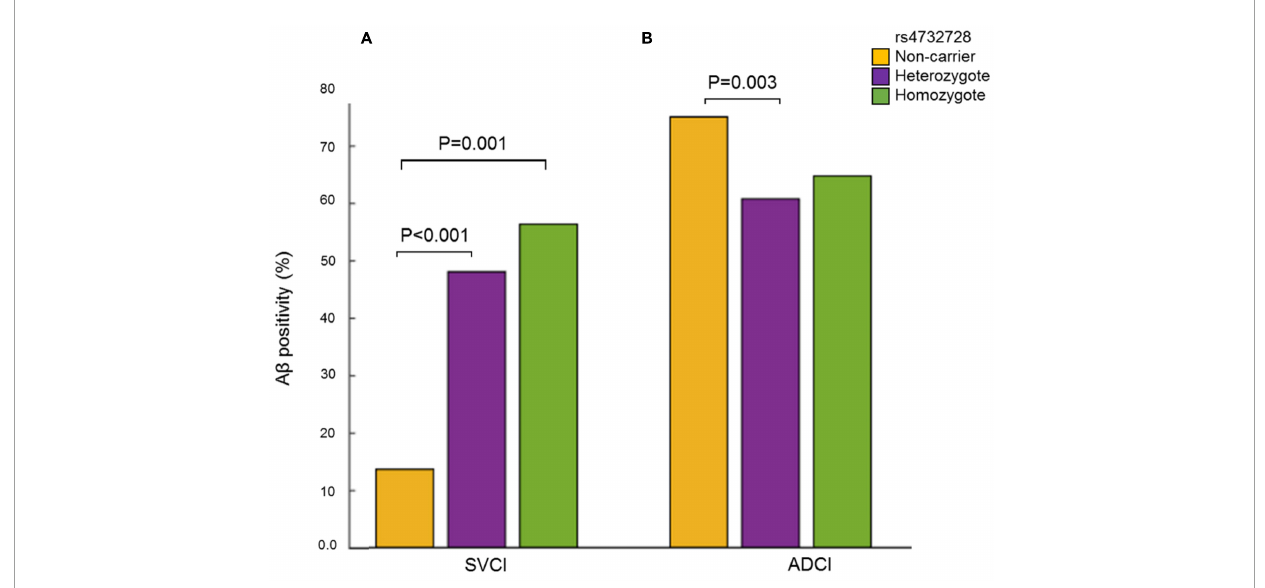
FIGURE1 Frequency of A β positivity according to carrier status of the rs4732728. (A) SVCI. (B) ADCI. P- values were calculated using the Chi-square test. A β , amyloid beta; ADCI, Alzheimer’s disease-related cognitive impairment; SVCI, subcortical vascular cognitive impairment.